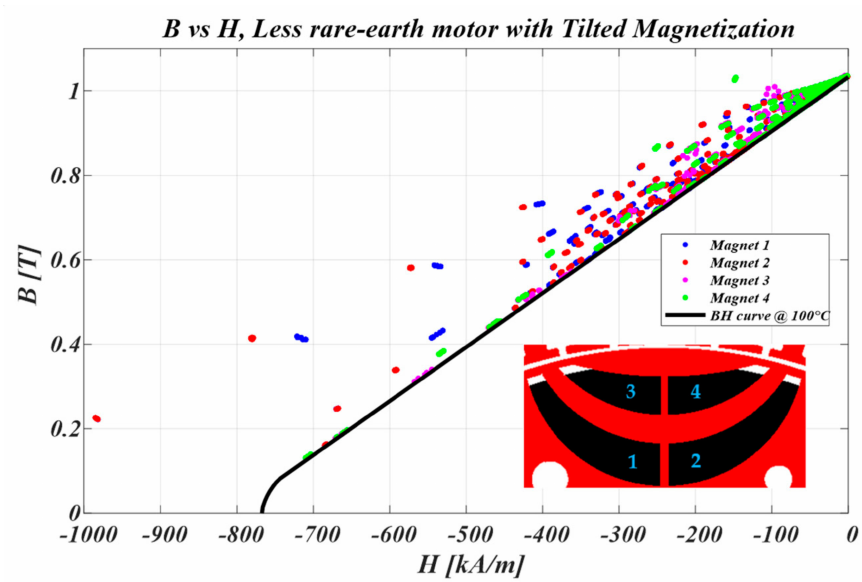
Figure 18. Less rare–earth motor candidate BH values and magnet demagnetization curve at 100 ◦